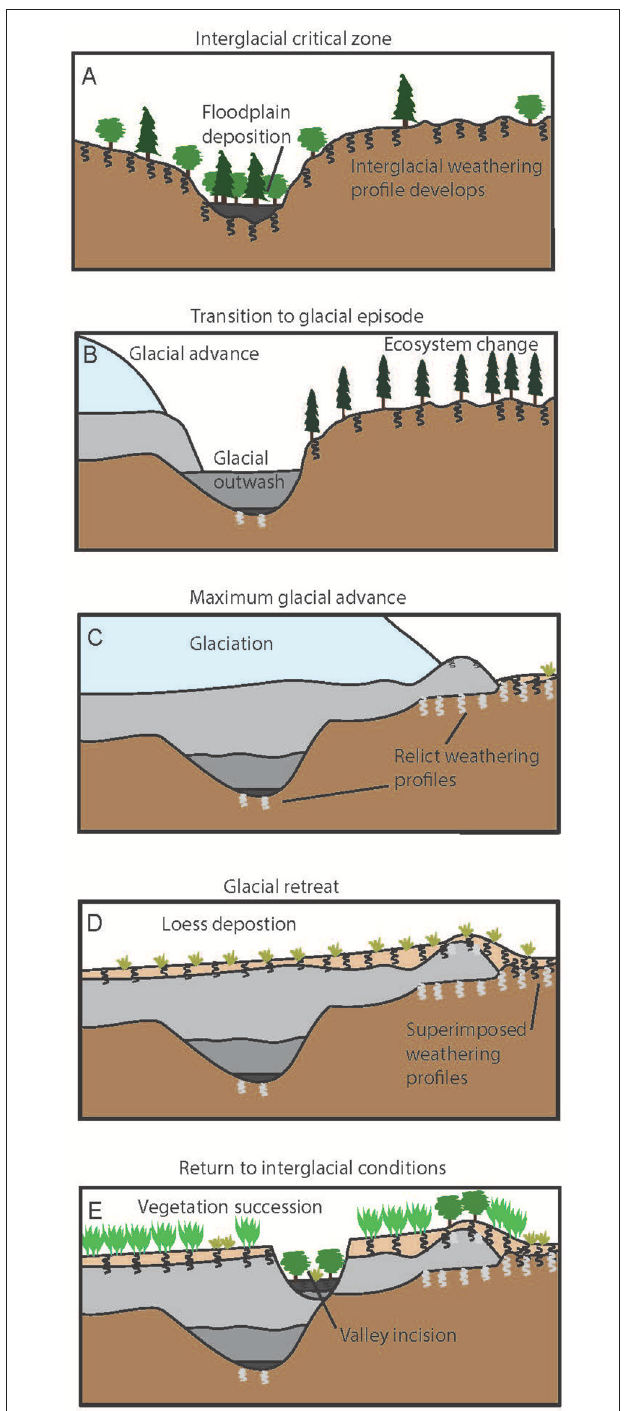
FIGURE 7 | Cartoon of idealized CZ evolution through a glacial cycle. (A) The landscape developed prior to glaciation. A Weathering profile (black squiggles) is developed in the surficial sediments, including alluvium (black) in the major river valleys. (B) As glaciers (light blue) crossed the region, they actively eroded their beds depositing glacial till (light gray). Sorted fluvial or lacustrine sediments (dark gray) were deposited in front of the ice margin